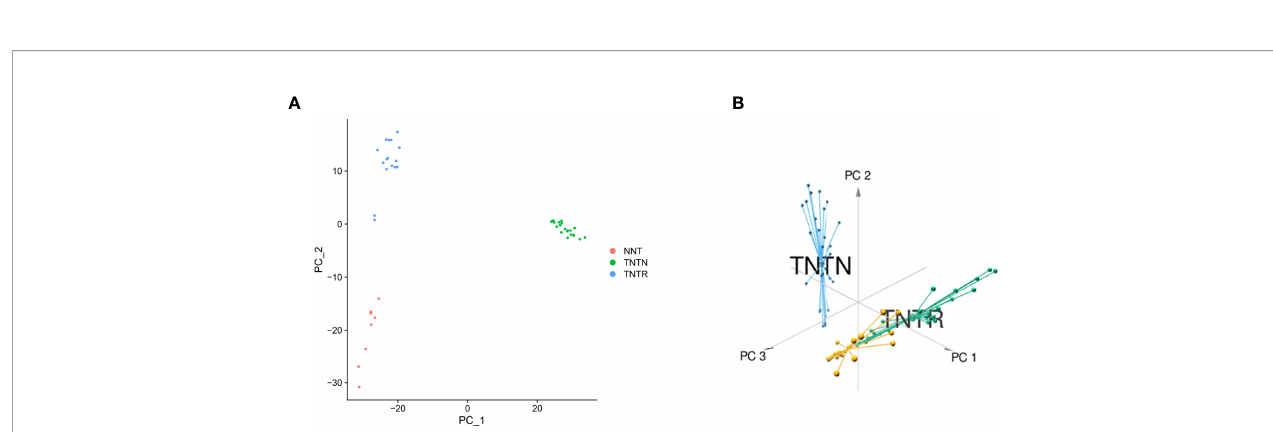
FIGURE 4 | Identi fi cation of principal CRT-related genes through PCA. (A) PCA could separate immune-related genes in GSE68204. Orange dots represent the normal (NNT) group; green dots represent the tumor-non-responsive (TNTN) group; blue dots represent the tumor-reponsive (TNTR) group. (B) 3D distribution plot of PCA. Orange lines represent the normal (NNT) group; green dots represent the tumor-responsive (TNTR) group; blue dots represent the tumor-non-responsive (TNTN) group.